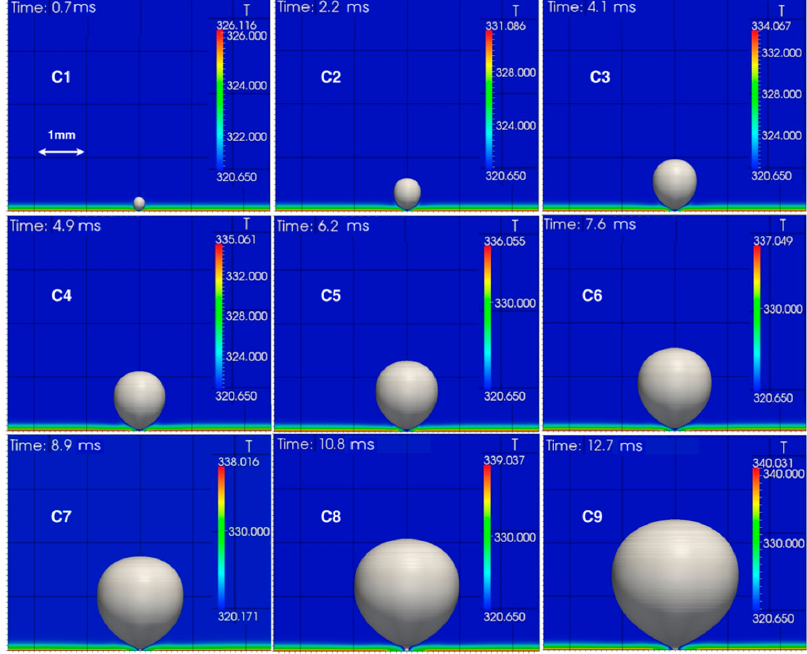
Figure 20. Spatial evolution of generated bubble at the time of detachment for each R113 case of the Series C parametric numerical simulations.